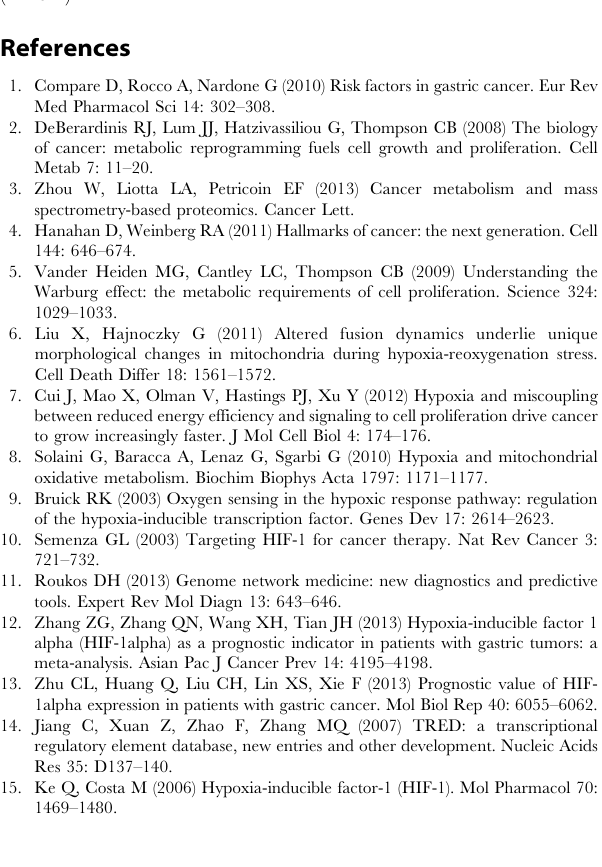
Figure S1 Western blot analysis of HIF-1 a in 10 pairs of gastric cancer and normal tissues. Table S1 Patients data. Table S2 Summary of 2546 differentially expressed genes in gastric cancer tissues compared to the distant normal tissues. Gene expression levels in gastric cancer tissues vs. the distant normal tissues were at least 2-fold different with a p- value , 0.05.